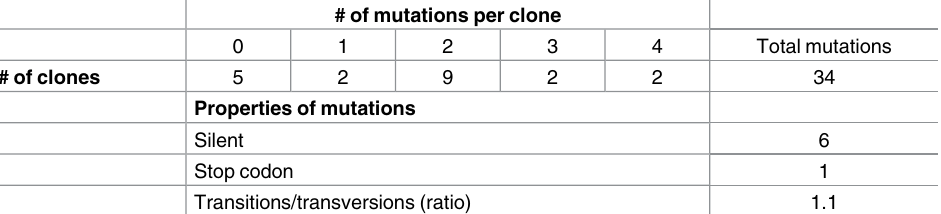
Table 2. Summary of sequencing results defining the quality of the random library (library 10, Table 1).